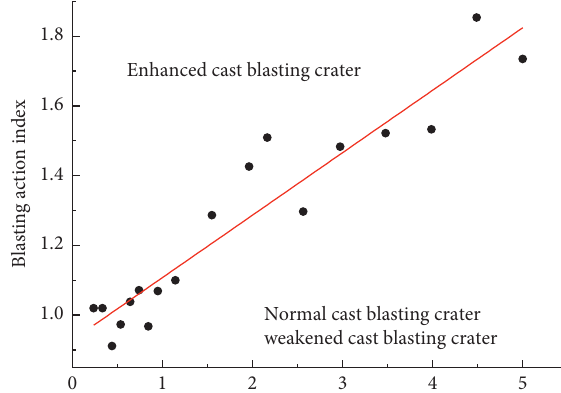
Figure 4: Peak pressure action coefficient – blasting action